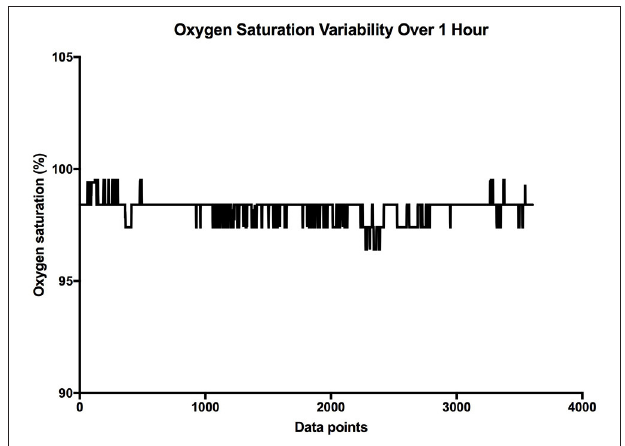
FIGURE 1 | Sample SpO 2 data collected over 1h. The X axis is the cumulative data points, and the Y axis is the oxygen saturation.